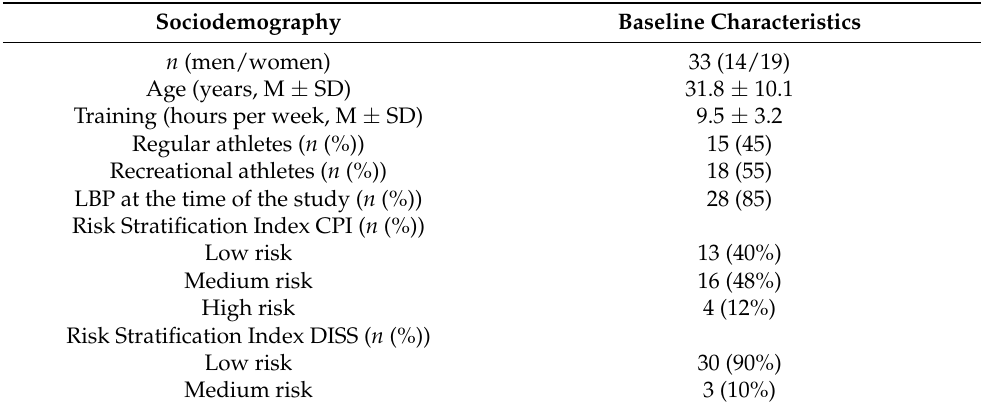
Table 1. Baseline characteristics of the study population.